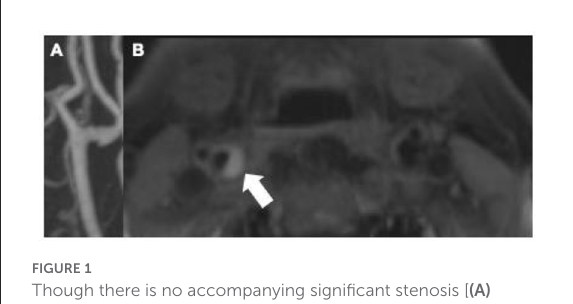
FIGURE1 Though there is no accompanying significant stenosis [ (A) maximum intensity projection of contrast-enhanced MRA], this MPRAGE sequence of the proximal right internal carotid artery in a 73-years-old male demonstrates a large T1